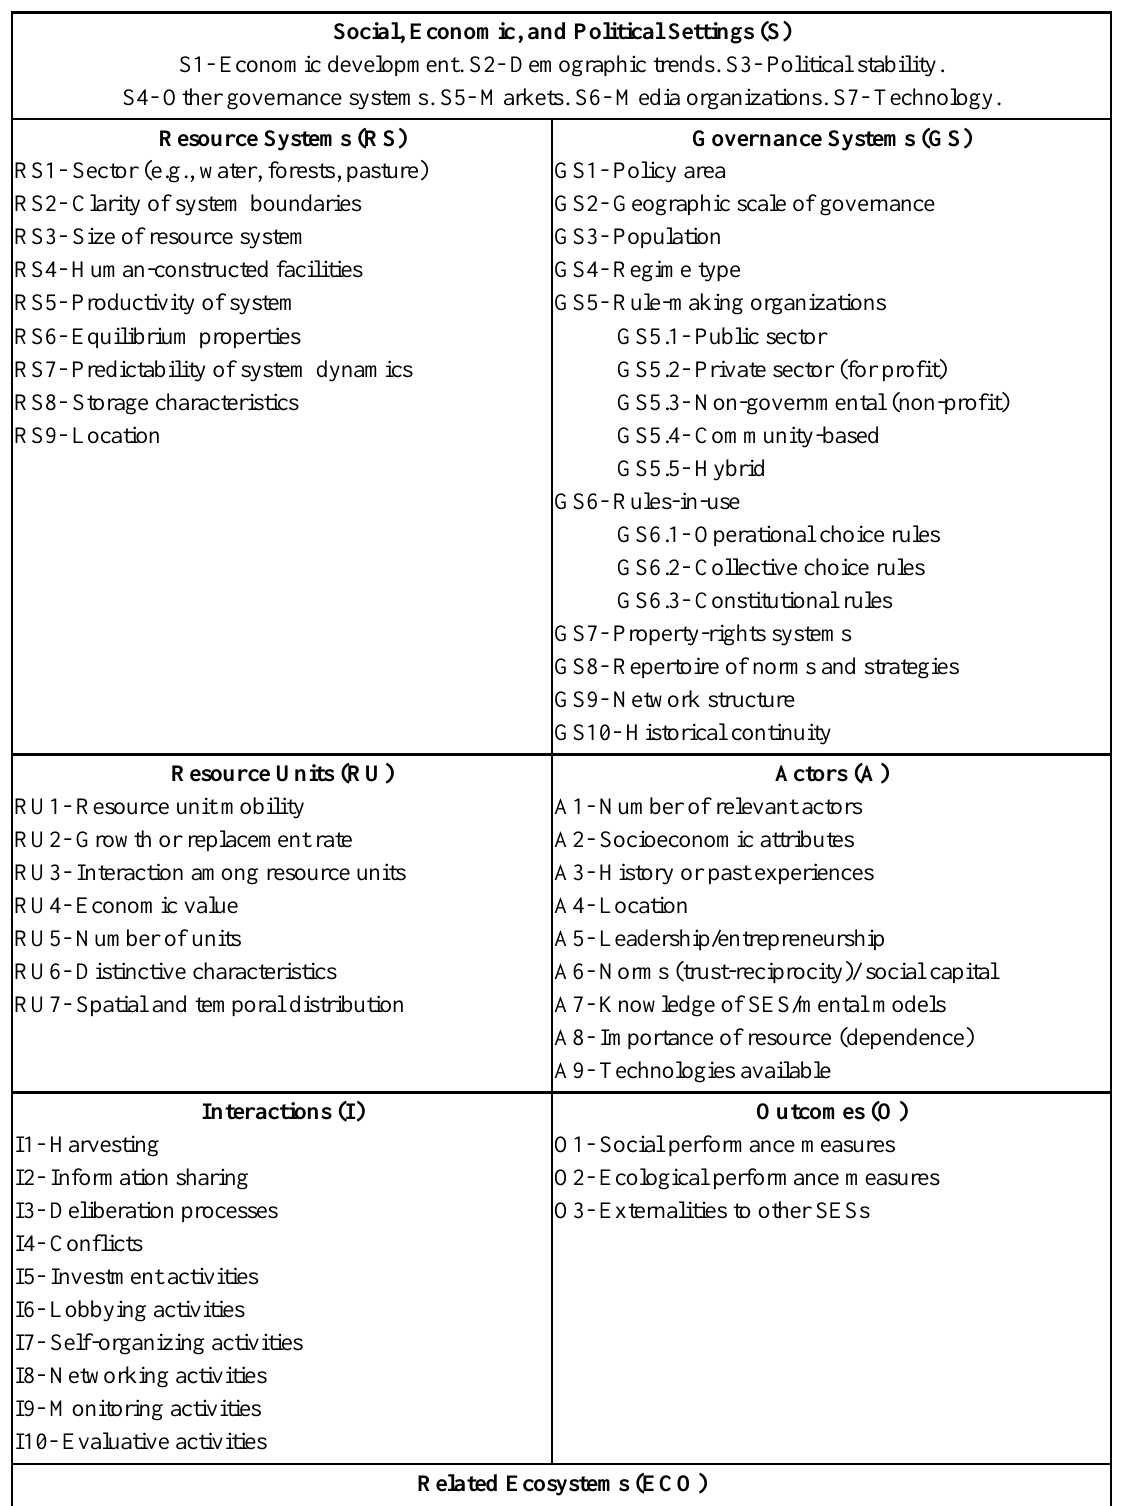
Table A1.1 The SES framework with second-tier variables alternative structure for Governance Systems (GS) proposed by McGinnis & Ostrom (2014) in table format. Followed by the visualization of the conceptual interactions between first-tier variables (McGinnis & Ostrom,